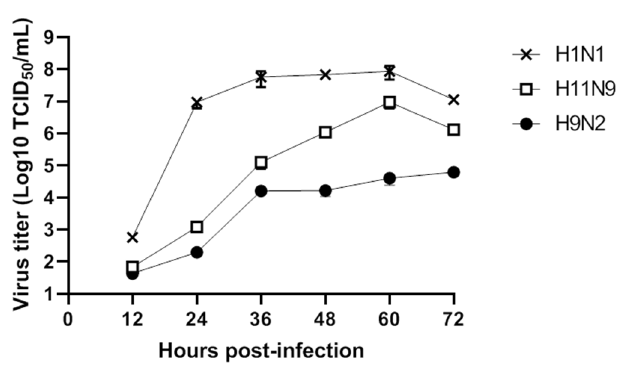
Figure 3. In vitro growth properties of H11N9 in Madin-Darby Canine Kidney (MDCK) cells. Virus titers were determined by using the 50% tissue culture infectious dose (TCID 50 ) assay. Cell monolayers were infected with viruses at an MOI of 0.001 and TCID 50 /mL of supernants was collected at different time for 72 h. At every 12 hours, the TCID 50 of supernatant of cells was measured by ELISA with anti-influenza nucleoprotein to determine the infected cells. The virus titers are means ± standard deviations (SD) ( n = 3).